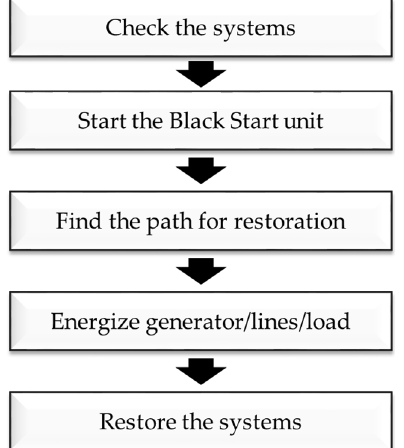
Figure 2. The general procedure of the black start service.